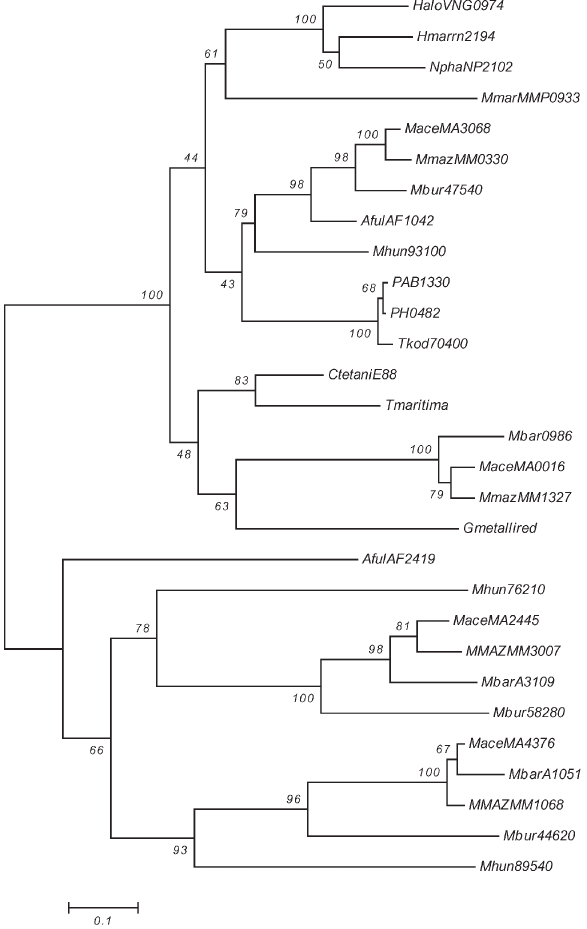
Figure 3. Phylogenetic analysis by neighbor-joining of putative two- component open reading frames (ORFs) from the response regulator I orphans arr7, arr10, arr12 and arr14 . Group arr7 = HaloVNG- 0974G, AfulAF1042, MmarMMP0933, Mbur_401647540, Mace- MA3068, MmazMM0330, PAB1330, PH0482, HmarrnAC2194, Tkod_610170400 , Mhun_401793100 and NphaNP2102A; group arr10 = MaceMA0016, MbarA_0986 and MmazMM1327; group arr12 = MaceMA4376, MbarA_1051, MmazMM1068,AfulAF2419, Mbur_401644620 and Mhun_401789540; and group arr14 = Mace - MA2445, MbarA_3109, MMAZMM3007, Mbur_401658280 and Mhun_401776210. The bacterial ORFs are CtetaniE88, Tmaritima and Gmetallired. Abbreviations: CtetaniE88 = C. tetani E88_1817- 150; Tmaritima = T. maritima MSB8_24050; and Gmetallired = G. metallireducens